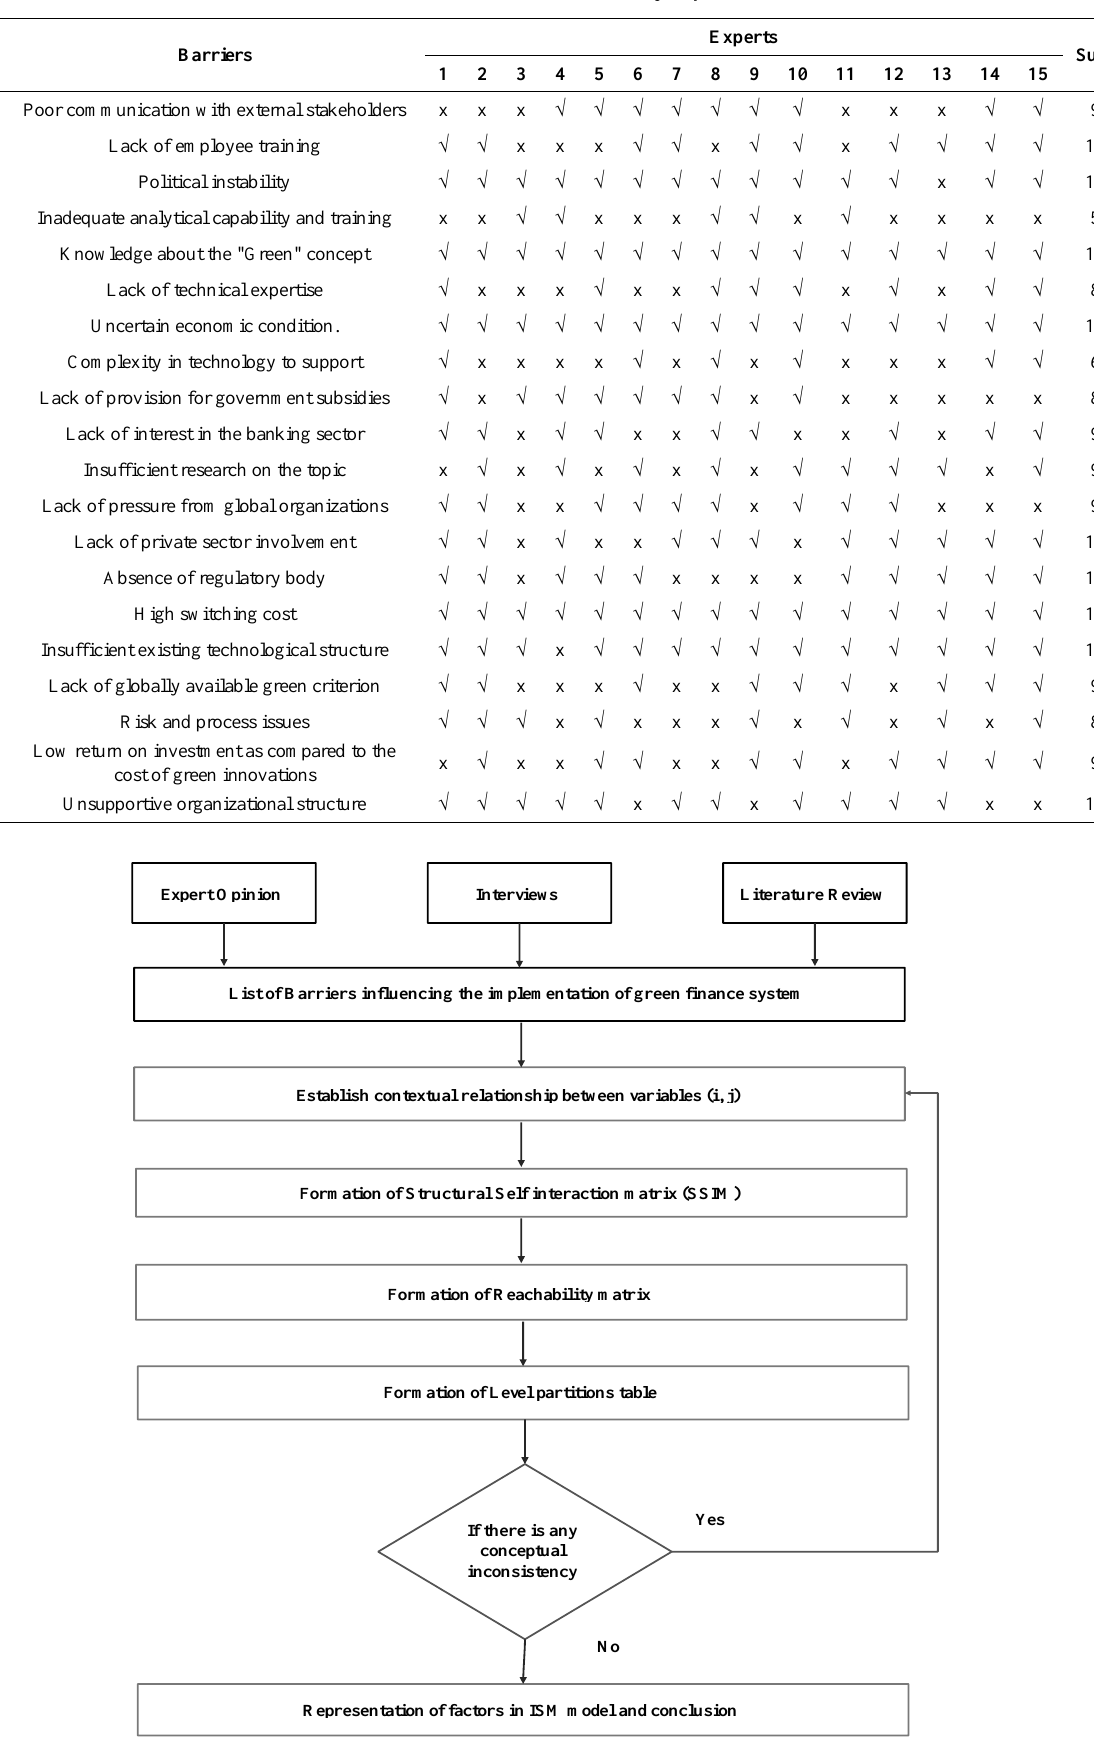
Figure 5. Steps of ISM